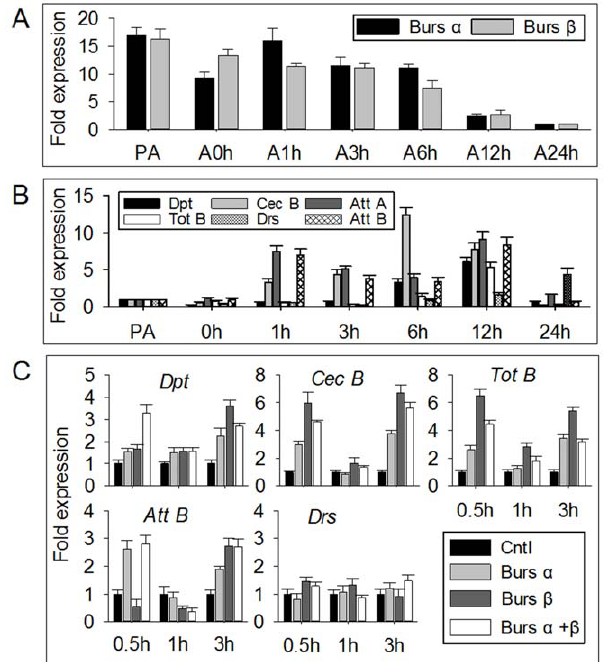
Figure 2. Transcription expression profiles of burs a and burs b subunits and AMP genes in pharate and newly-emerged adults. qPCR analysis (A) of bursicon a and b gene expression in pharate (PA) and eclosed adults (A) 0–24 h after eclosion; qPCR analysis (B) of AMP gene expression in pharate and eclosed adults 0–24 h after eclosion; Transcription expression ( C ) of AMP genes in 24 h-old adults injected with blank vector transfected sample, r-burs a 2 a homodimer, r-burs b 2 b homodimer and r-burs a 2 b heterodimer, respectively.